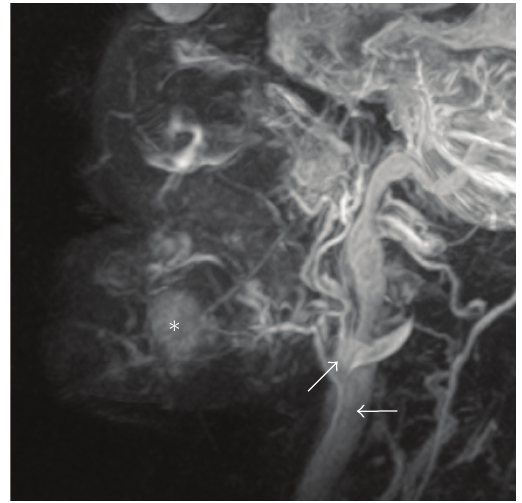
Figure 5: MRA by 3D-FBI in a 79-year-old patient with heman- giomas of the left oral floor. Both hemangiomas and thin blood vessels around tumor can be clearly visualized on MRA with 3D-FBI. The carotid arteries (arrow), internal jugular vein (black arrow), lingual artery, lingual vein, facial artery, facial vein, maxil- lary artery, and maxillary vein are identified as bright homogeneous linear structures. At the same time, hemangiomas (star) are clearly visualized as the mass with a high signal intensity. Acquisition time was 3 minutes and 28